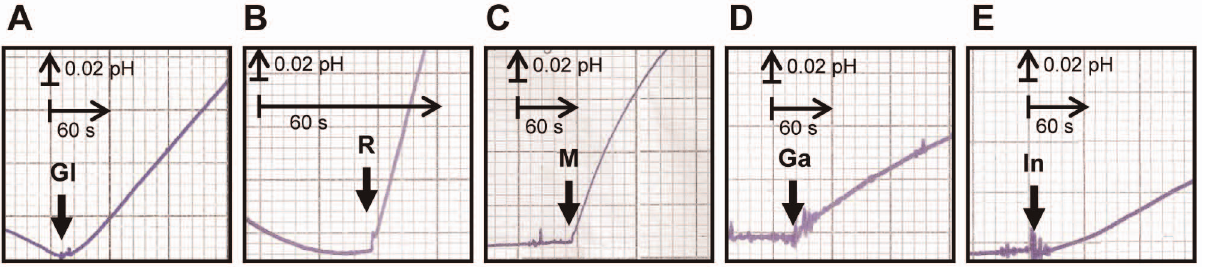
Figure 4. Symport activity in S.cerevisiae strains expressing D.hansenii polyol transporters. Effect on extracellular pH elicited by addition of 10 mM glycerol (Gl), ribitol (R), D-mannitol (M), D-Galactitol (Ga) or D-( + )- chiro -inositol (In) to unbuffered cell suspensions (pH 5) of S. cerevisiae strains MLY8 (A), MLY9 (B), MLY12 (C), MLY22 (D) and MLY23 (E), grown on YNB medium with 2% maltose. The arrows indicate the times of polyol addition. Data are representative of at least two independent